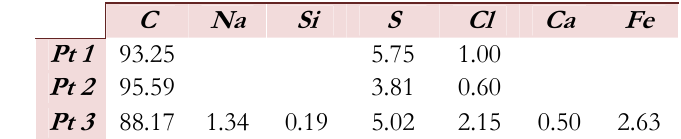
Figure 19: SEM analysis. Porous particles from the surface crust – 700 X.